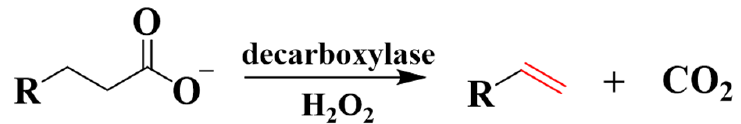
Figure 6. Enzymatic fatty acid decarboxylation.